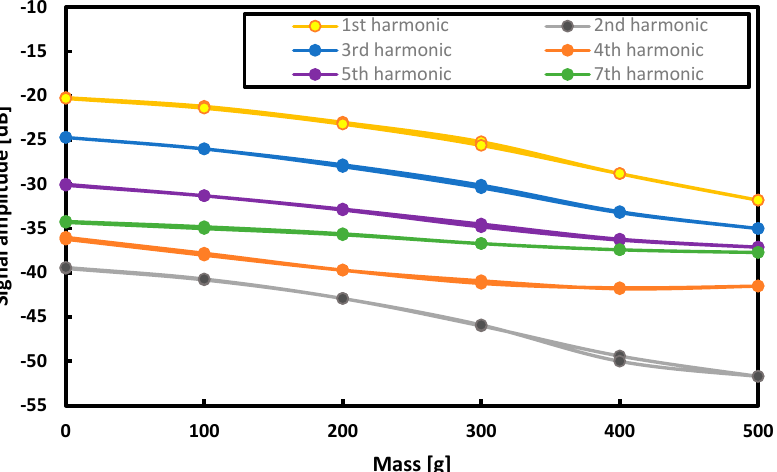
Figure 9. The results of the measurement of the signal amplification measured at the given loads for successive harmonics.